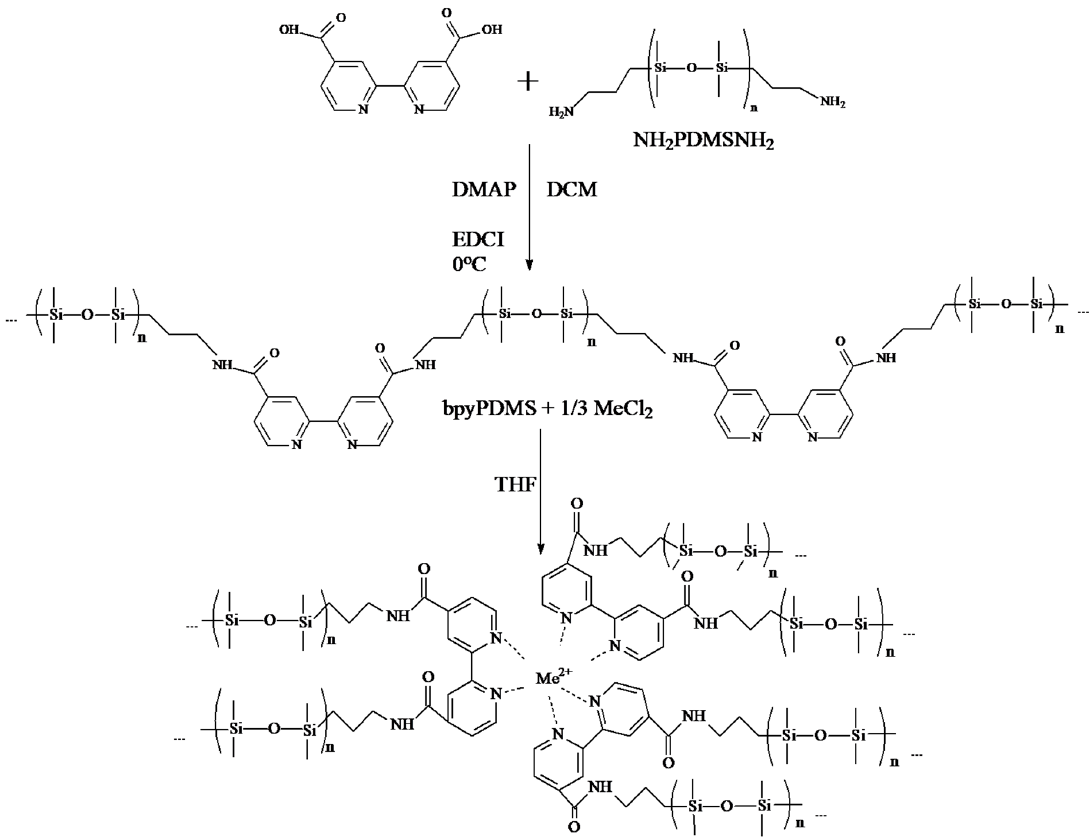
Figure 1. Synthesis scheme and molecular structure of the bpyPDMS-Me(II) system.